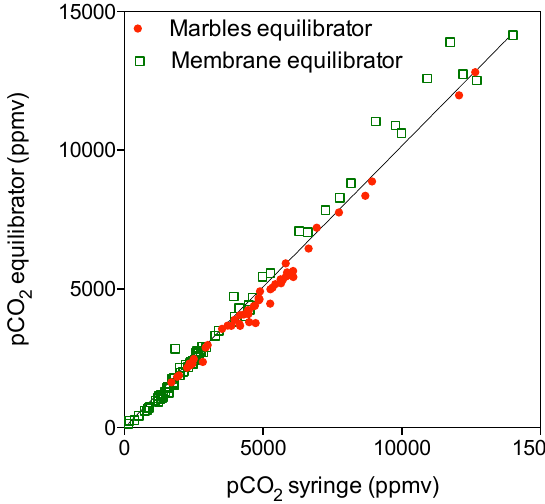
Figure 2. Comparison of results of different water–air equilibra- tion designs for direct p CO 2 measurements; p CO 2 measured with a marbles equilibrator (Congo) and with a membrane equilibrator (Congo and Zambezi) are plotted against p CO 2 measured with a syringe headspace technique. Detection was made with an IR gas